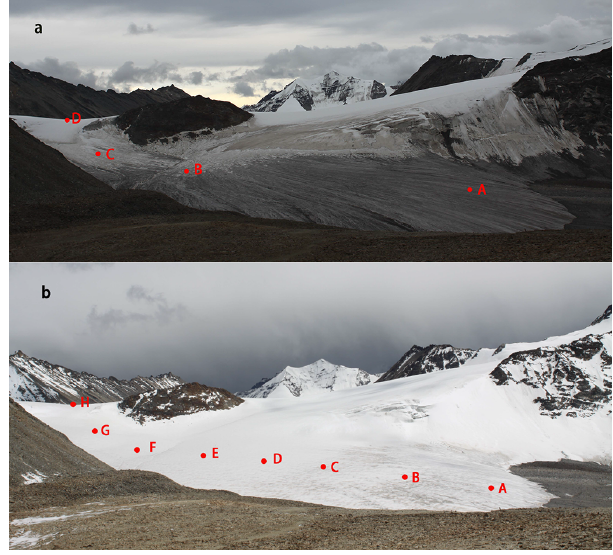
Figure 2. Surface features of the Zhadang glacier on 16 July (a) and 26 August (b) . The two surface conditions include three types of melting conditions: S-I: sites A and B, which are located in the su- perimposed ice belt (Fig. 2a); S-II: sites C and D, which are in the upper area of the glacier (Fig. 2a); S-III: all sites were covered by fresh snow (Fig.